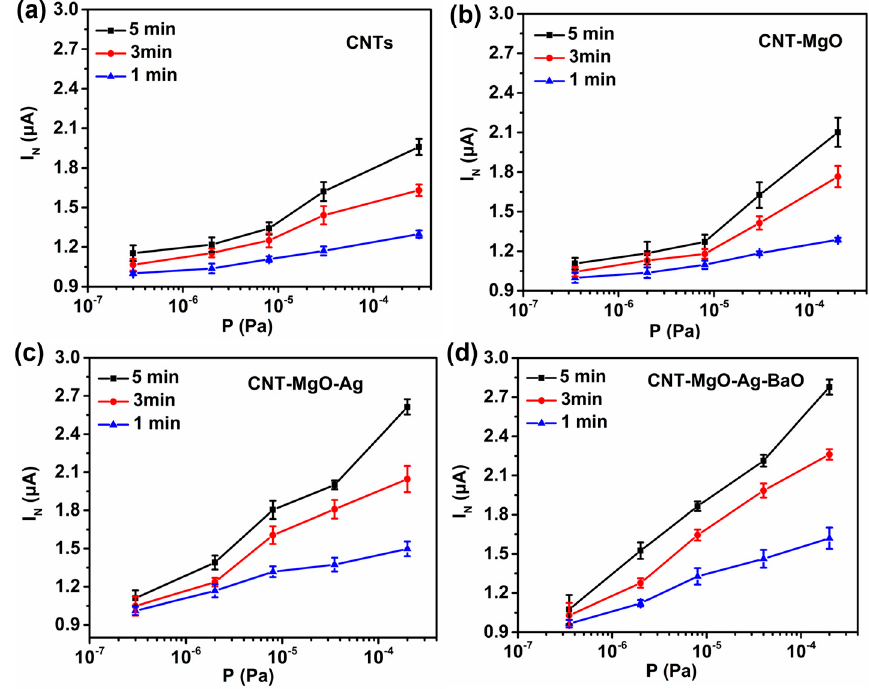
Figure 7. Pressure sensing performances of the CNTs and CNT-based composite samples. ( a ) CNTs; ( b ) CNT-MgO; ( c ) CNT-MgO-Ag; ( d ) CNT-MgO-Ag-BaO.